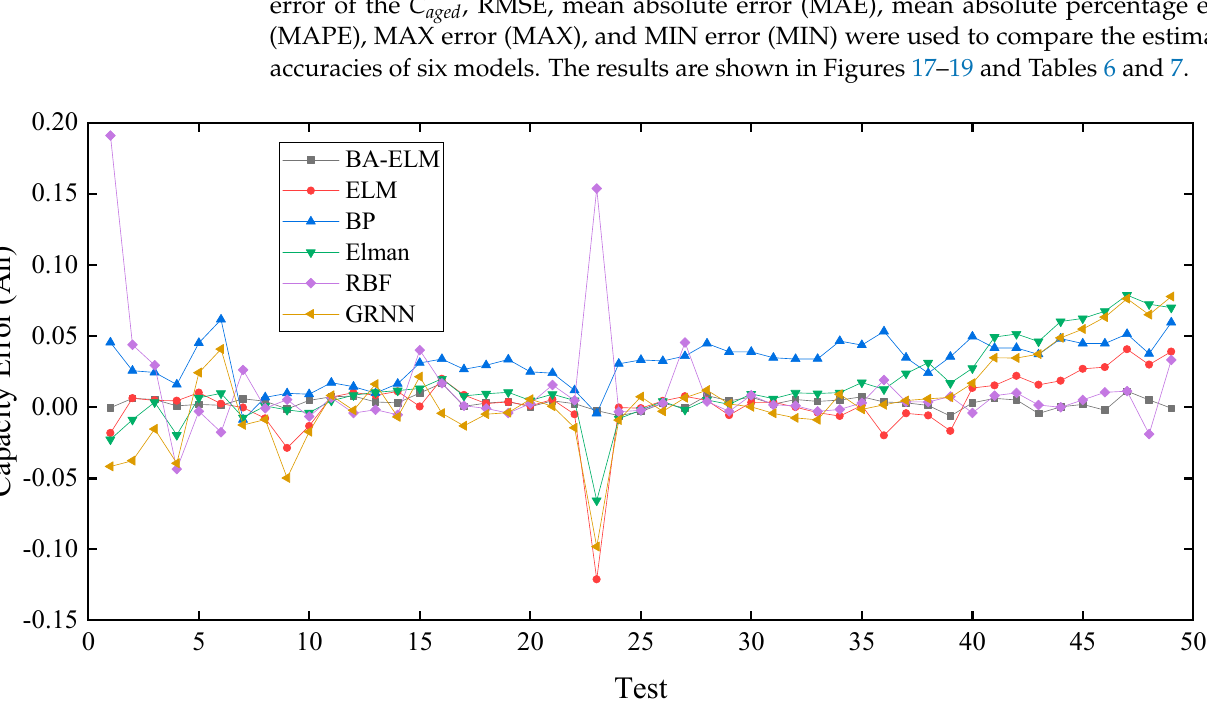
Figure 17. Comparison of estimation errors of C aged of each model.